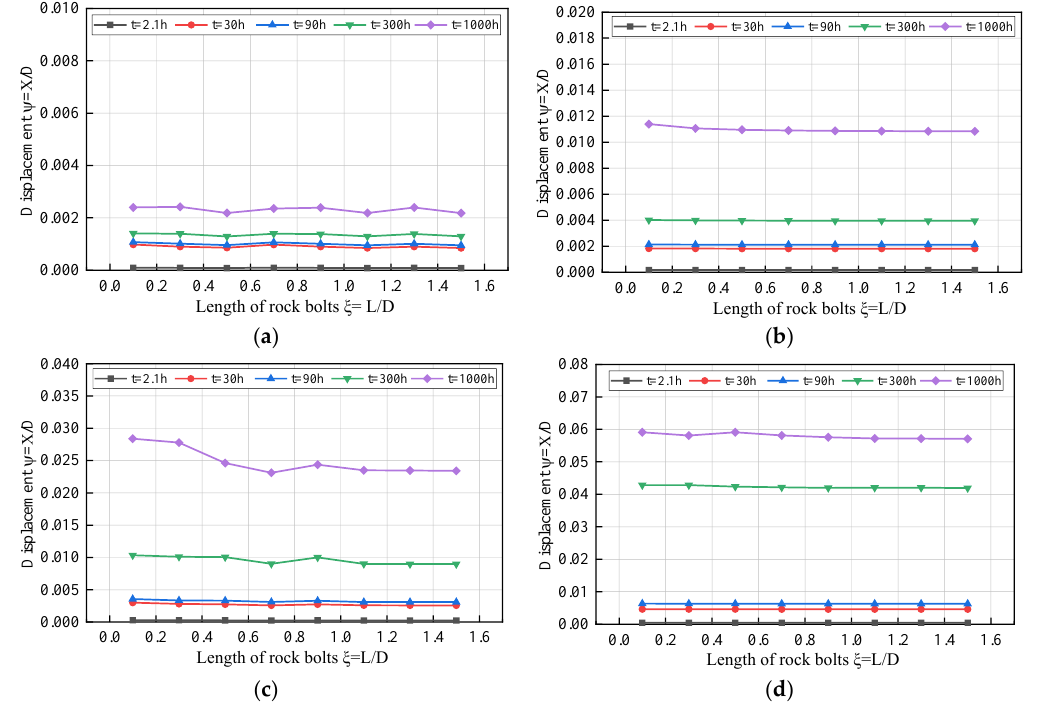
Figure 12. Surrounding rock displacement and rock bolt length with different in situ stresses: ( a ) β = 0.8 (Class A); ( b ) β = 0.4 (Class B); ( c ) β = 0.26 (Class C); ( d ) β = 0.16 (Class